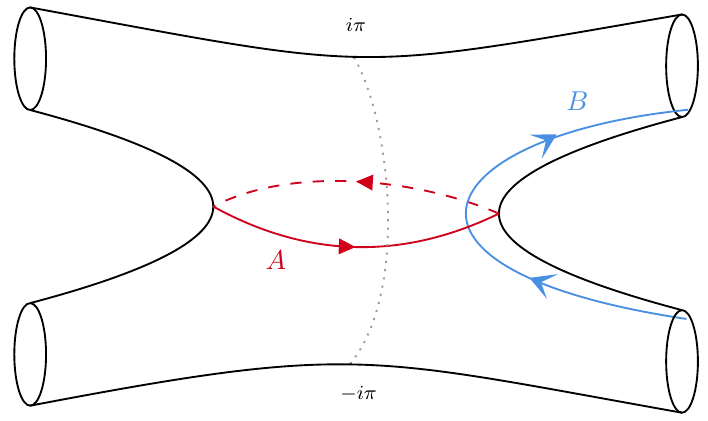
Figure 2 . The A and B -cycle contours for Chern-Simons theory. Note that the Riemann sheets are curled up due to the 2 πi periodicity of the